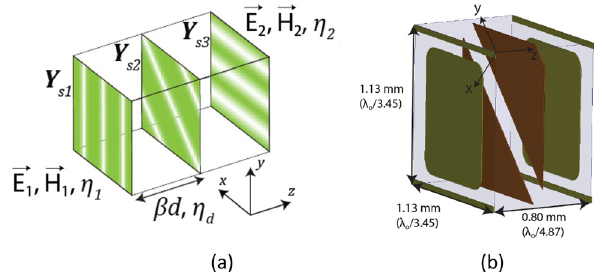
Figure10: (ReprintedwithpermissionfromRef.[15])(a)Metasurface consisting of patterned plasmonic sheets (anisotropic sheet admittances) separated by optically thin dielectric layers. The metasurface can be designed to exhibit electric, magnetic, and chiral constituent surface parameters. (b) An example of a designed bianisotropic metasurface that acts as an asymmetric circular polarizeratmm-wavefrequencies.Thisunitcellconvertsanincident right-handed circular polarization to left-handed circular polariza- tion, but completely re fl ects incident left-handed circular